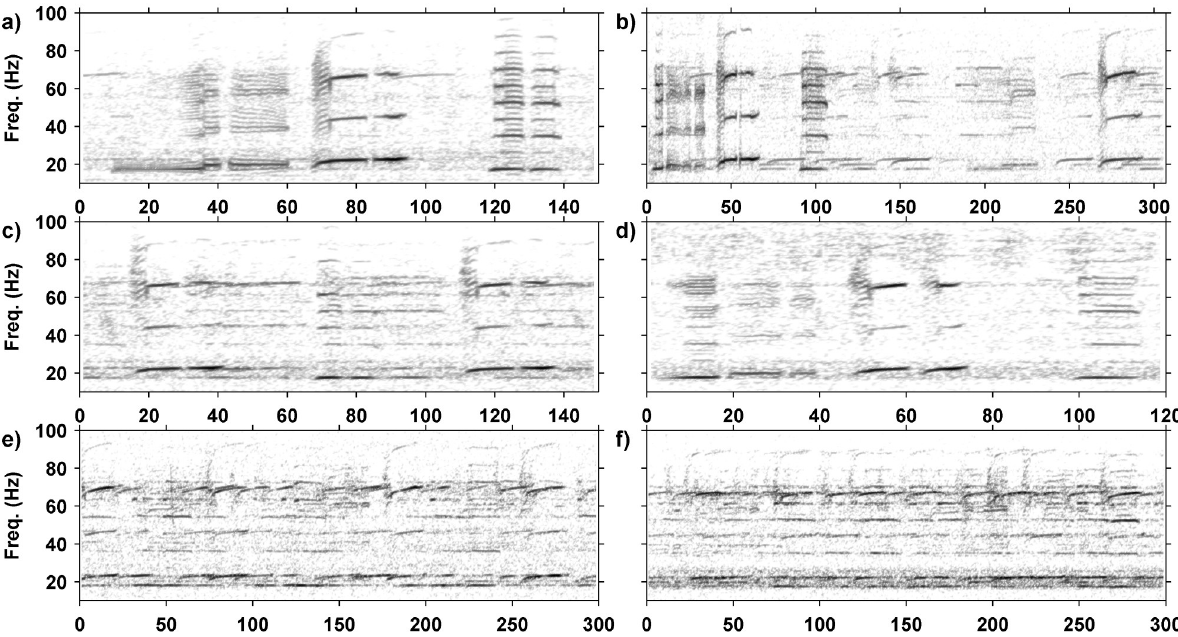
Fig 8. Spectrograms of pygmy blue whale song phrases showing broken units and periods of many singers. Spectrograms of pygmy blue whale song with broken units (a-d) and 5–7 overlapping callers (e-f), made with a 2048 point FFT, 0.8 overlap using a 1 kHz sample rate (0.488 Hz and 0.41 s frequency and time resolution, respectively). The x-axis is time in s, the y-axis is common for all panels. Shown are: a) a P3 phrase with all three song units broken; b) a P3 phrase variation with only the type I and type II units broken; c) a P2 phrase variant with both units broken; d) a P3 phrase with the type I and II units broken; and e) and f) multiple singers (matched 300 s